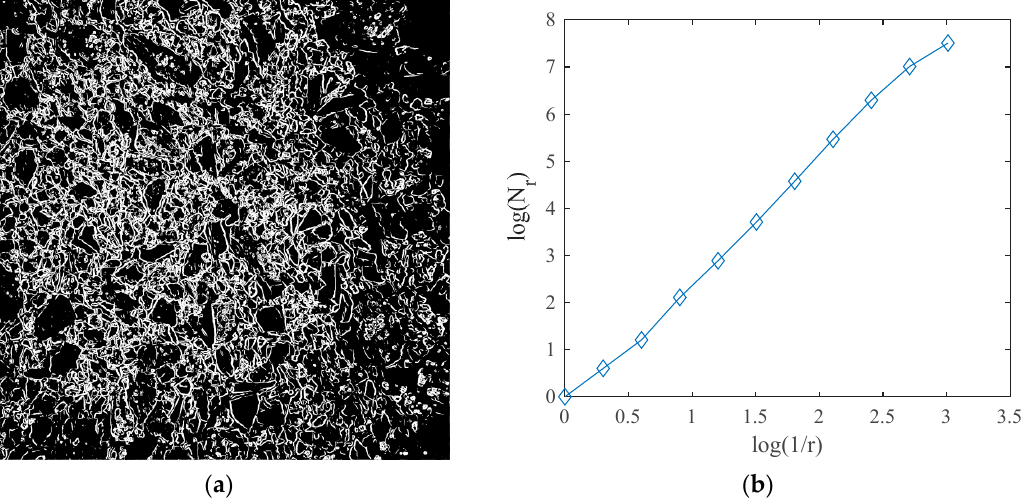
Figure 3. The image fractal dimension of coal edge in different scale. ( a ) Original coal-edge image ( b ) Fractal dimension.